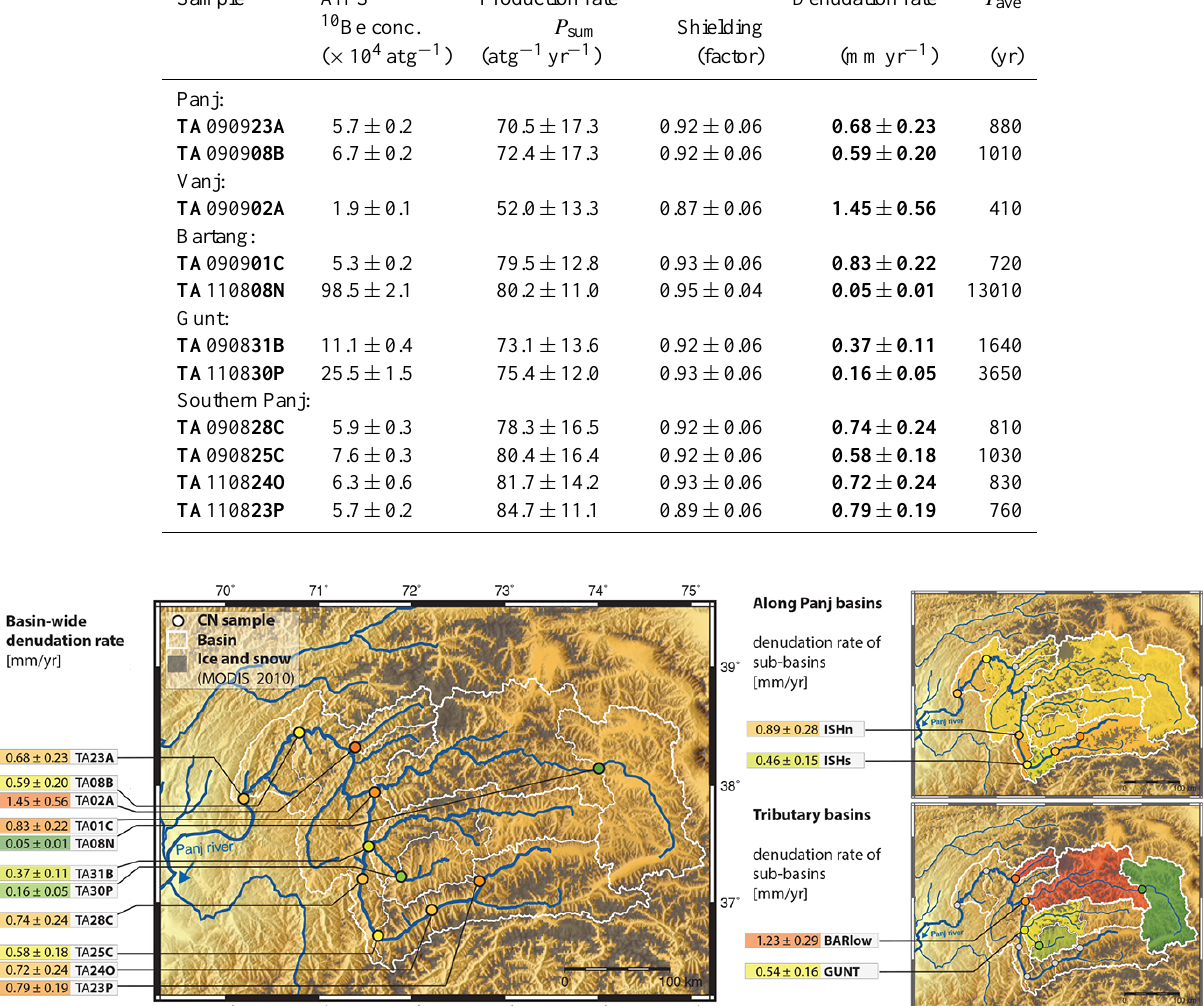
Figure 3. Basin-wide denudation rates of along Panj and major tributary samples (CN: cosmogenic nuclide; colour code represents mag- nitude of denudation with green for low and red for high rates). Calculations based upon AMS measurements of 10 Be concentrations in modern fluvial sediments and GDEM processing for production rates and topographic shielding. Denudation rates of the sub-basins ISHn, ISHs, BARlow and GUNT represent slope-weighted estimates inferred from sampled basins (corresponding up- and downstream basins) and using derived measurement results from Eq. 3 (for details see text and Table